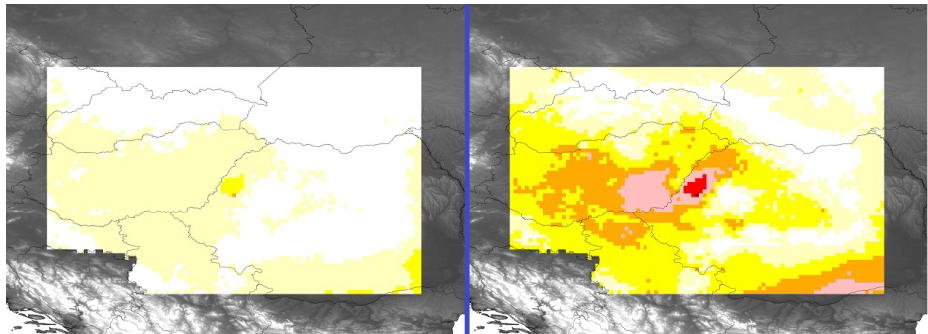
Figure 6. Palfai Aridity and Drought Index: mean value in 1964–2010 (left), 2003 (right). See Table 2 for